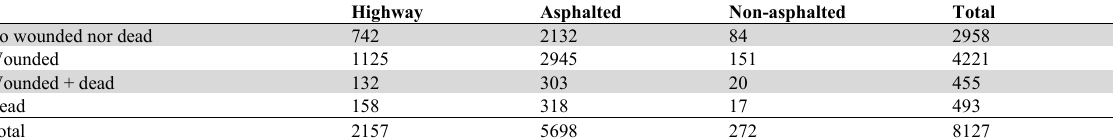
Descriptive statistic between accident severity and road type